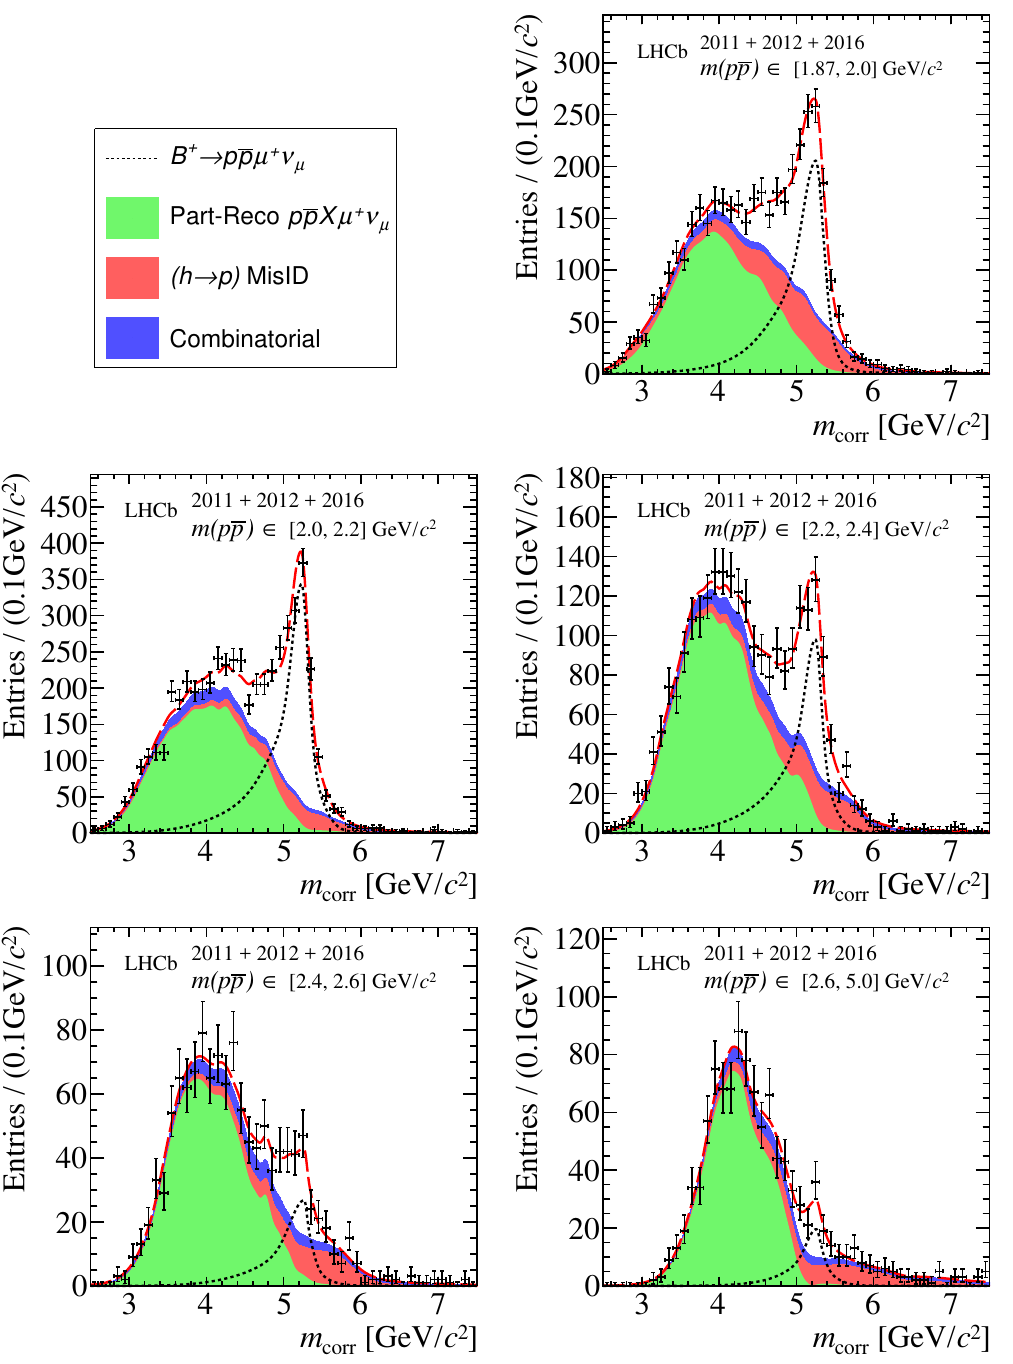
Figure 3 . Distributions of m corr in each m ( pp ) bin with the (cid:12)t results shown.